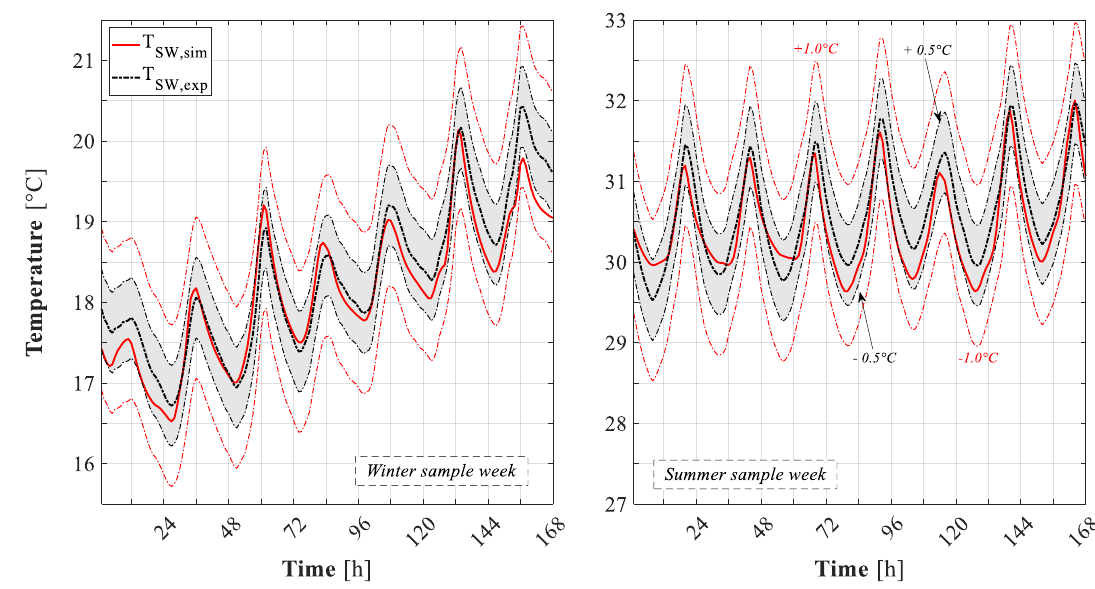
Figure 14. South-West wall temperature: simulated vs. experimental results (two sample weeks).